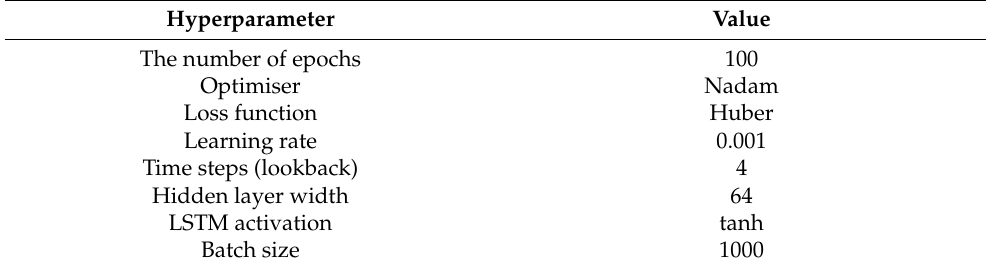
Table 3. Optimal hyperparameters found for this